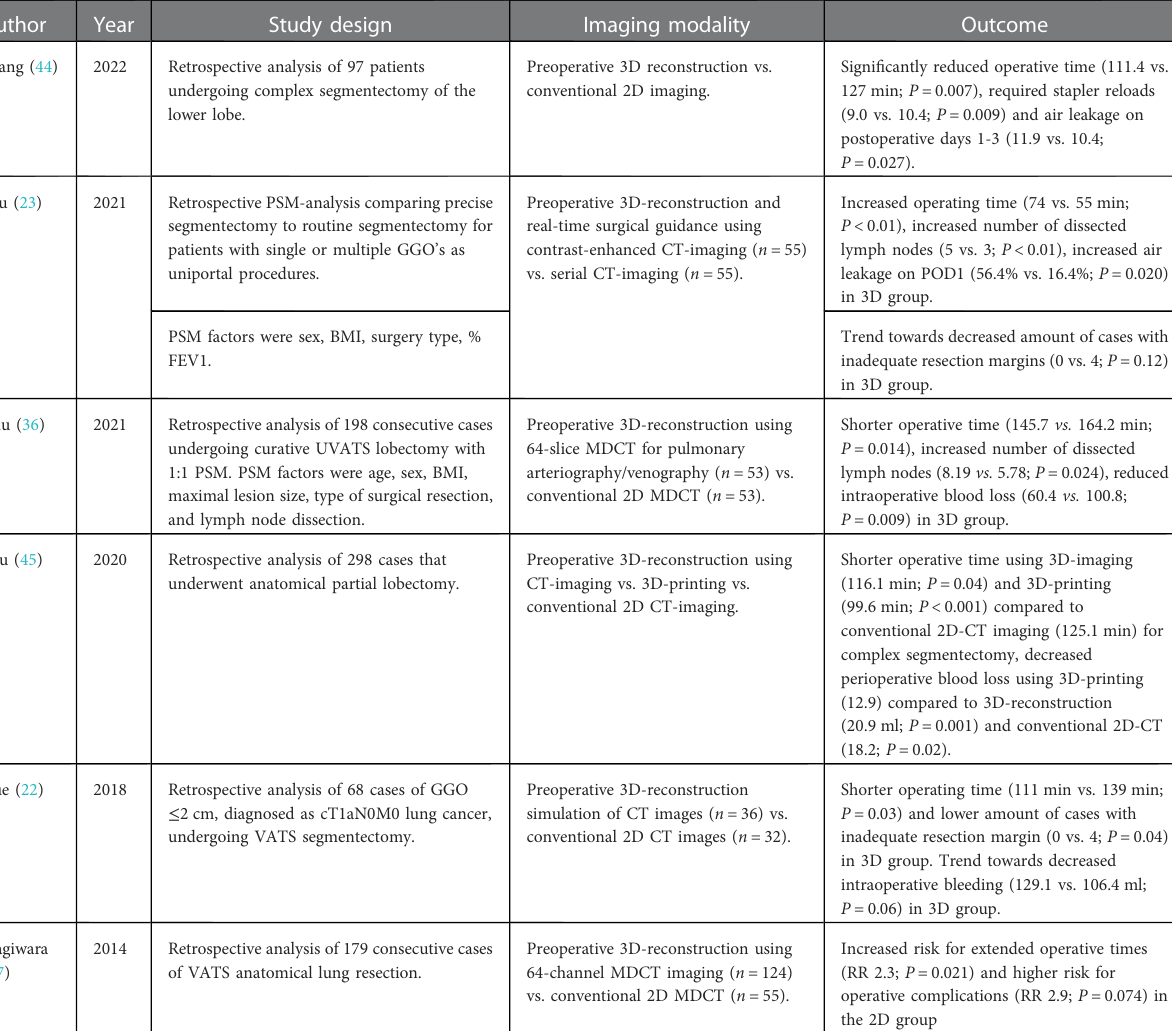
TABLE 1 Summary of the results from comparative studies regarding perioperative outcome. PSM: propensity score-matched; GGO: ground glass opacity; BMI: body mass index; FEV1: forced expirational volume in 1 s; 3D: three-dimensional; CT: computed tomography; POD: postoperative day; (U)VATS: (uniportal) video-assisted thoracoscopic surgery; MDCT: multidetector CT; RR: risk